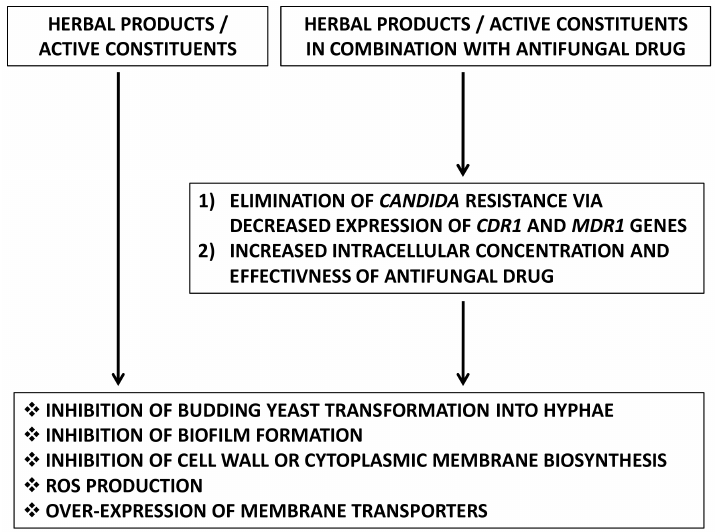
Figure 2. The mechanism of action of herbal products and their active constituents used alone and in combination with antifungal drug against drug-resistant Candida